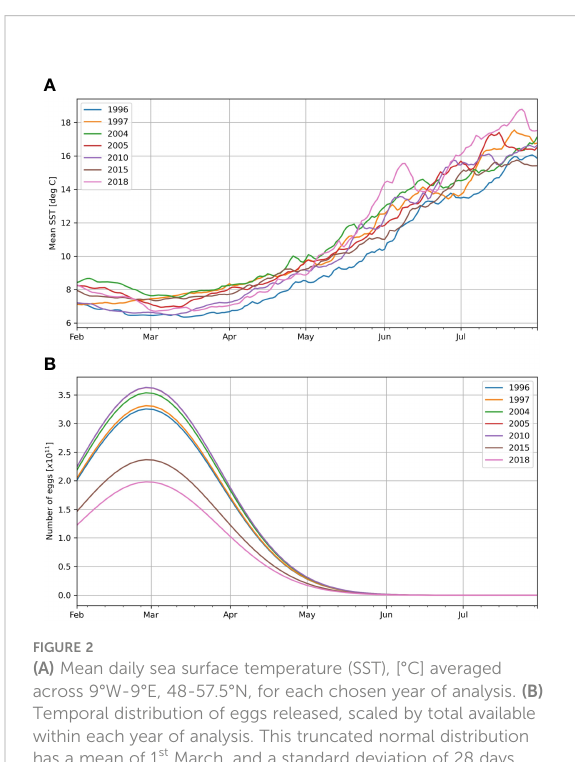
FIGURE 2 (A) Mean daily sea surface temperature (SST), [°C] averaged across 9°W-9°E, 48-57.5°N, for each chosen year of analysis. (B) Temporal distribution of eggs released, scaled by total available within each year of analysis. This truncated normal distribution has a mean of 1 st March, and a standard deviation of 28